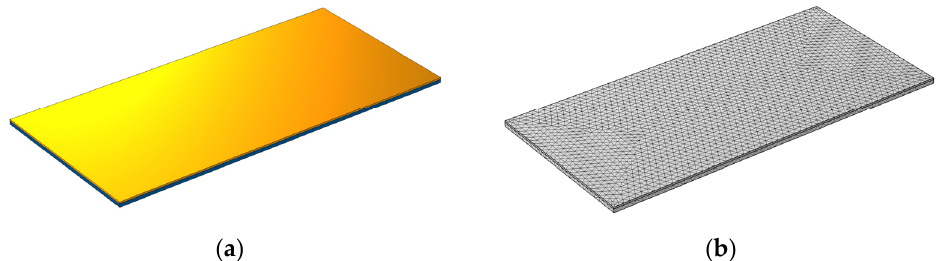
Figure 6. The geometrical model of the rectangular beam: ( a ) geometrical model in COMSOL Multiphysics and ( b ) meshed model.